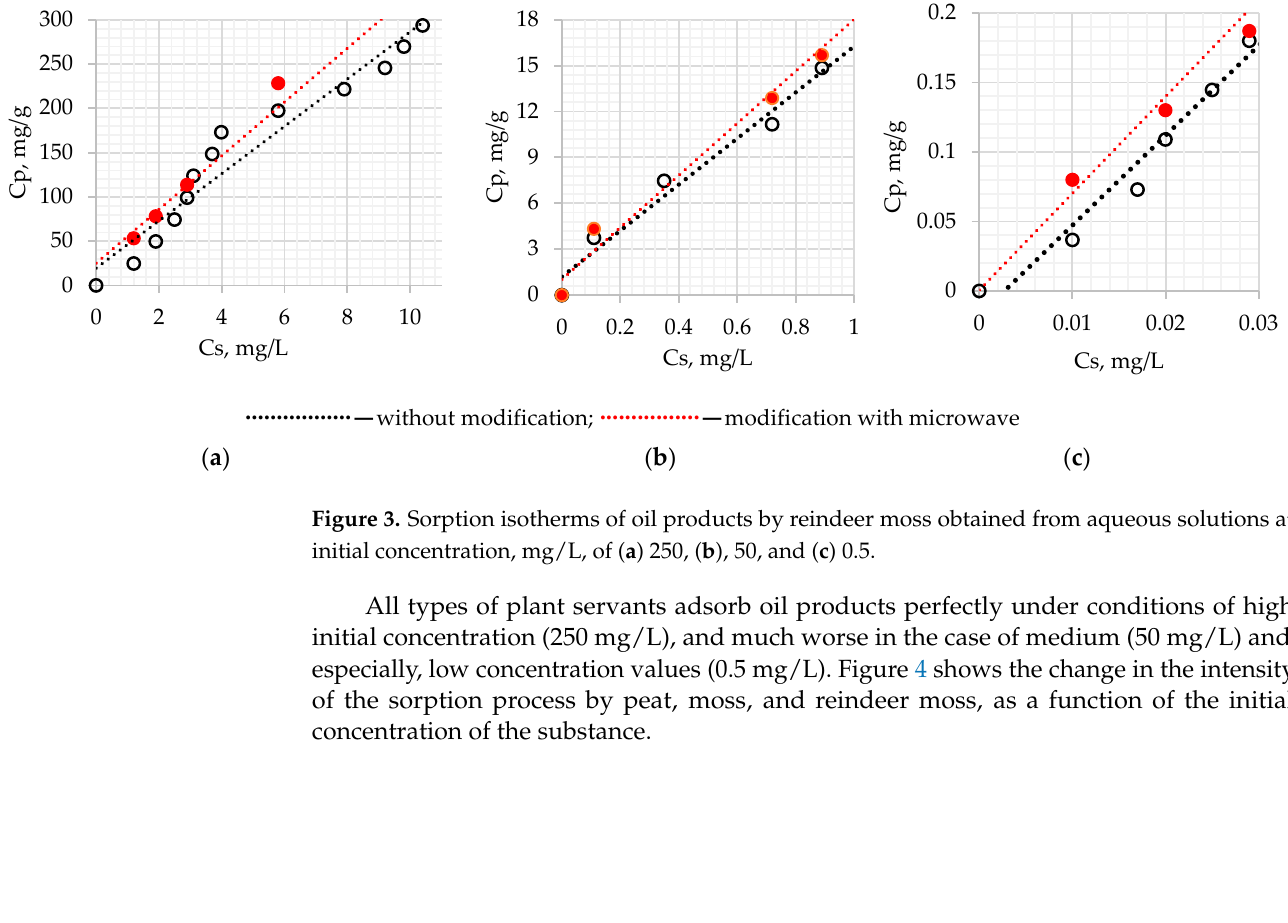
concentration of the